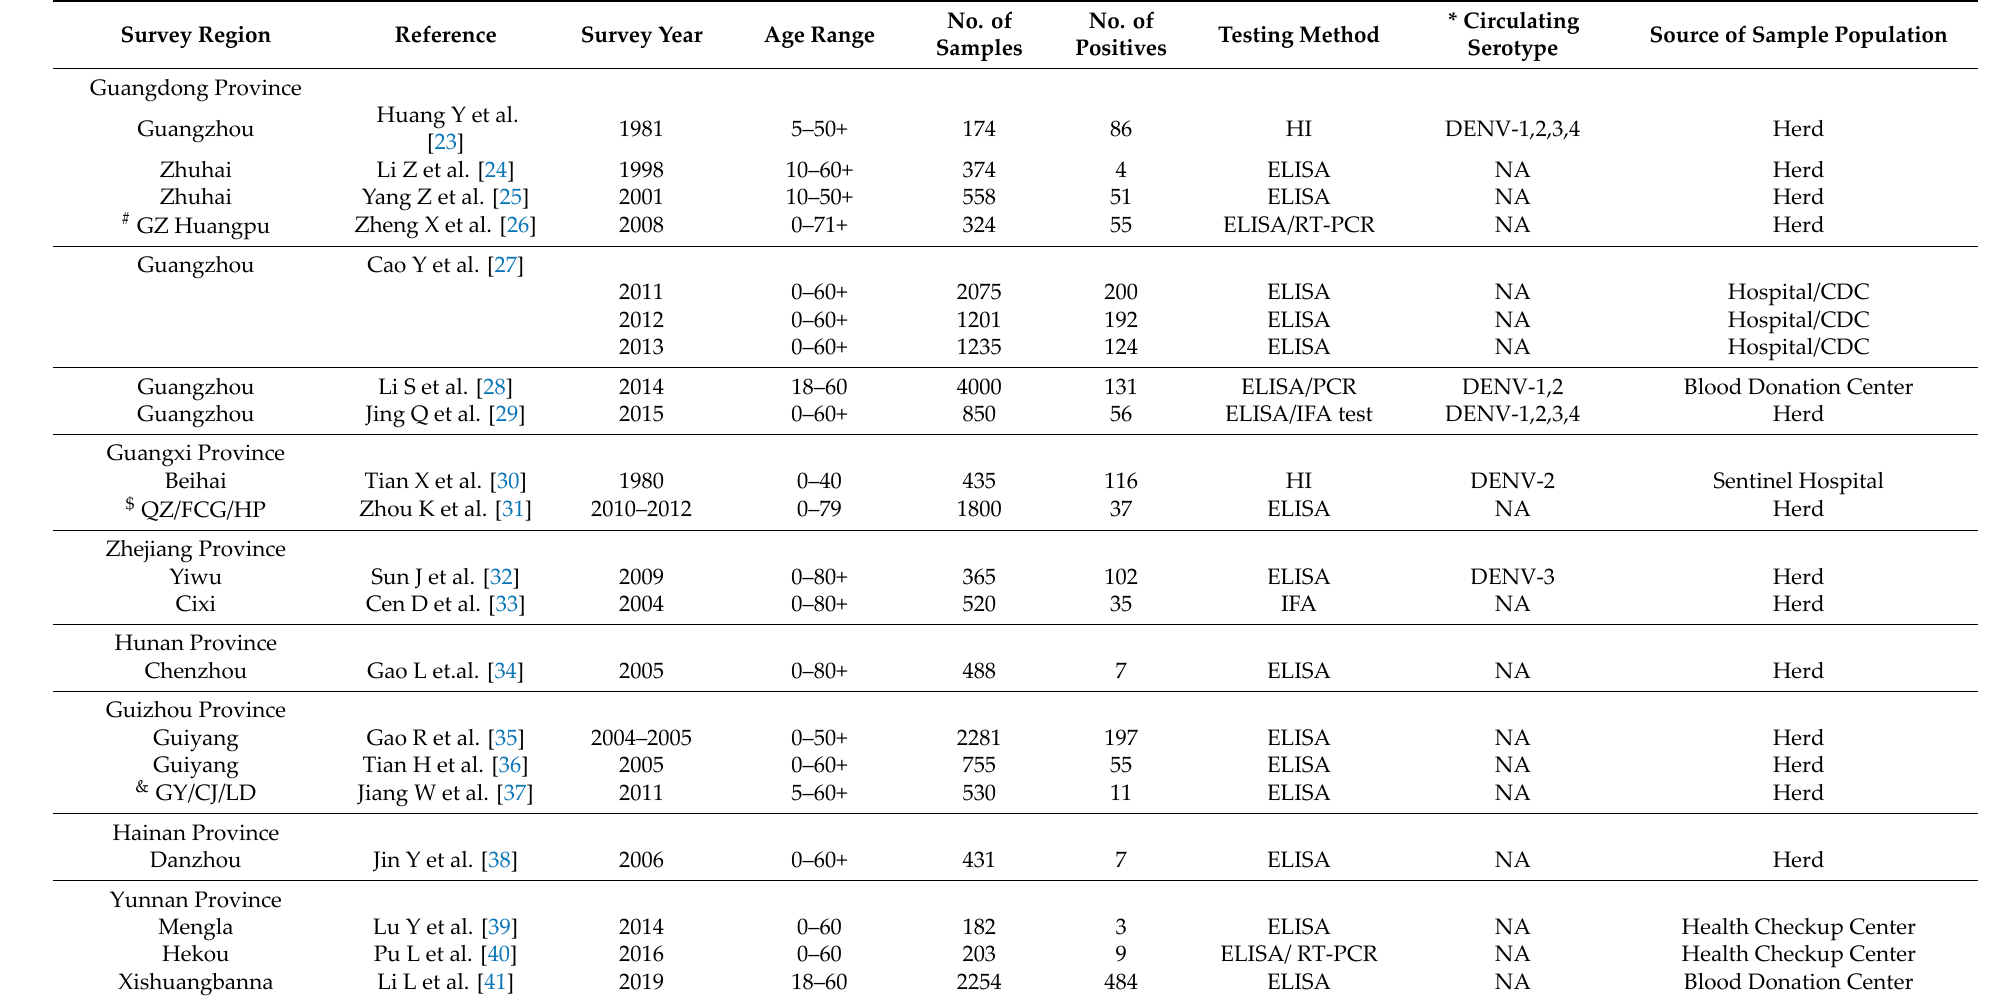
Table 1. 23 studies for estimation of dengue transmission intensity in